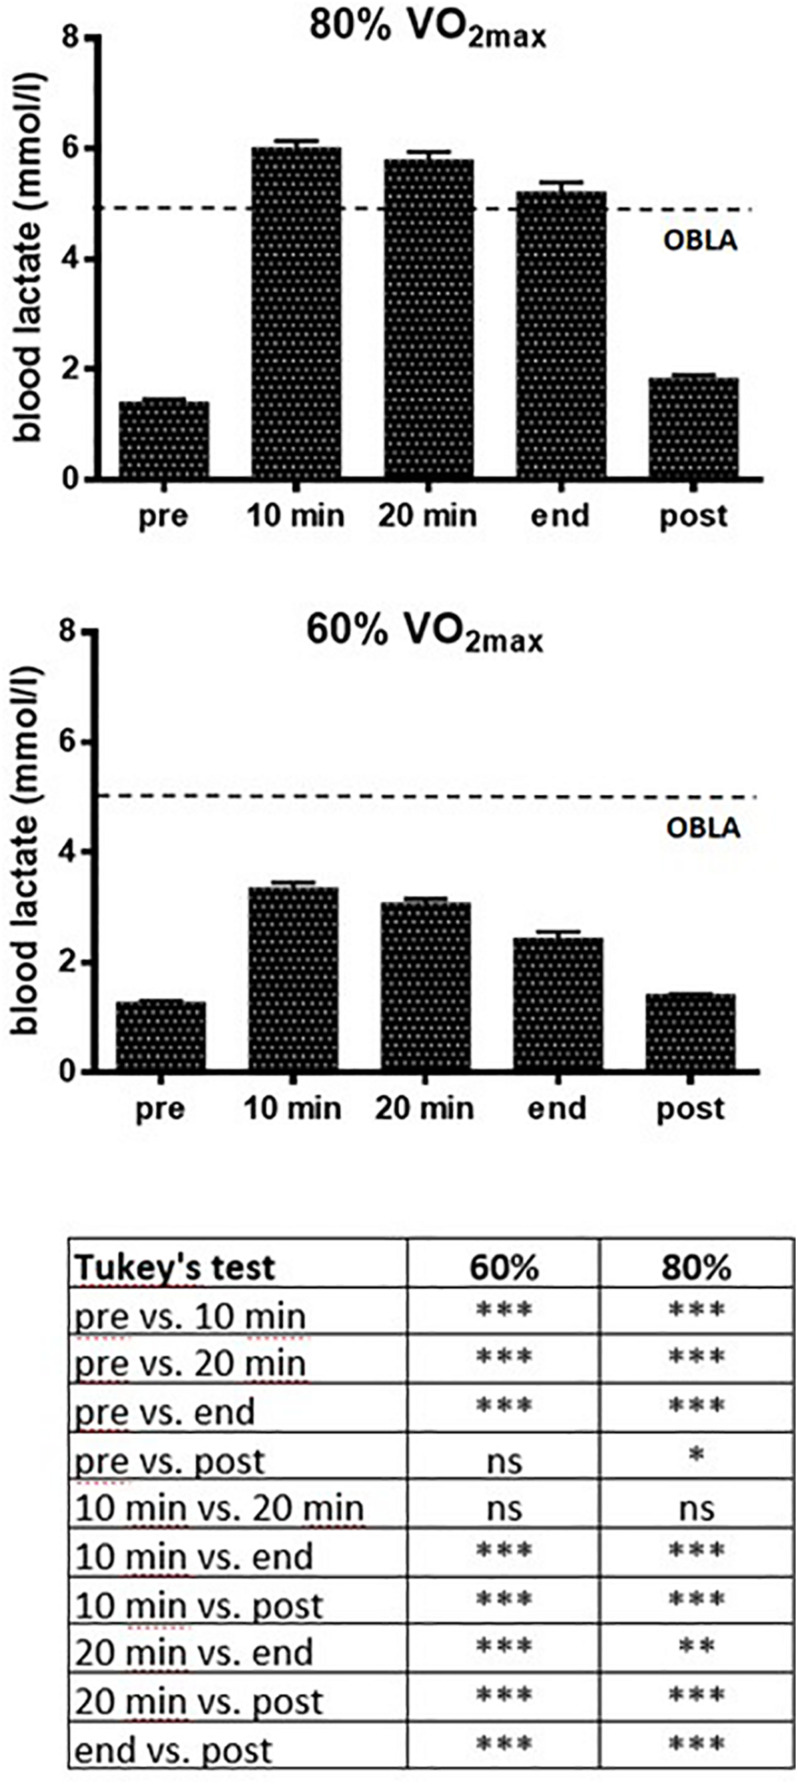
Blood lactate levels (mean values ± SD) of the 20 participants performing a voluntary 30-min exercise at 60 and 80% VO2max. Measurements were carried out every 10 min before the exercise (pre), during the 30-min exercise, and 10 min after the conclusion (post). The dotted line indicates the level (4 mmol/l) of the Onset of Blood Lactate Accumulation (OBLA). Results of Tukey’s Multiple Comparison Test carried out on data are also presented. ANOVA with Tukey’s multiple comparison test are the following: ∗p < 0.05, ∗∗p < 0.01, ∗∗∗p < 0.001.